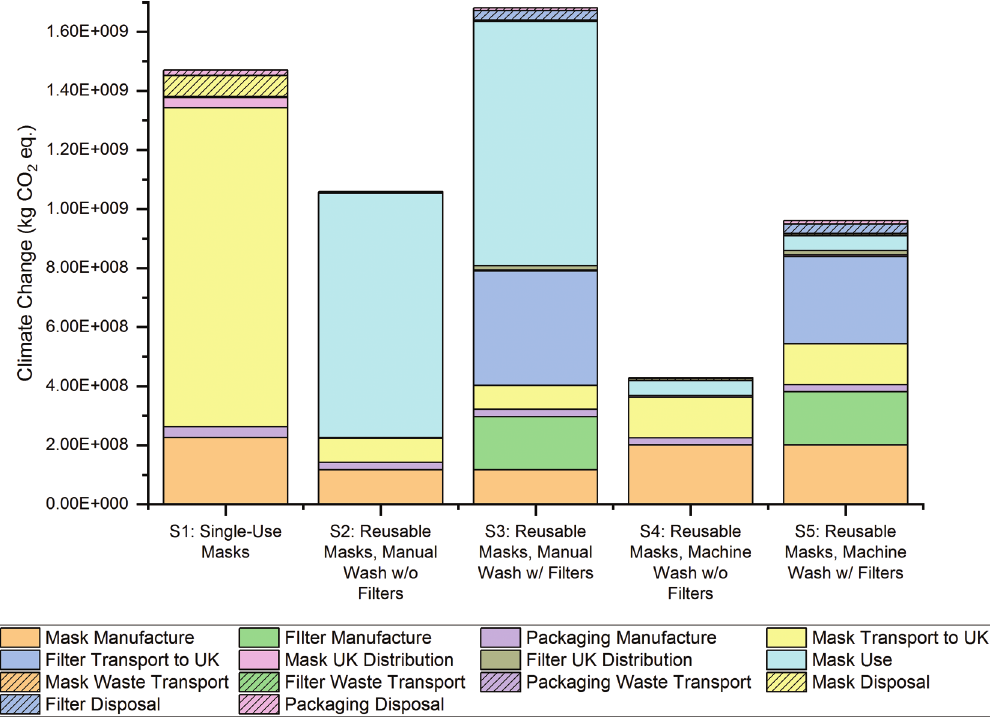
Figure A2 Climate change results generated for each scenario of face mask